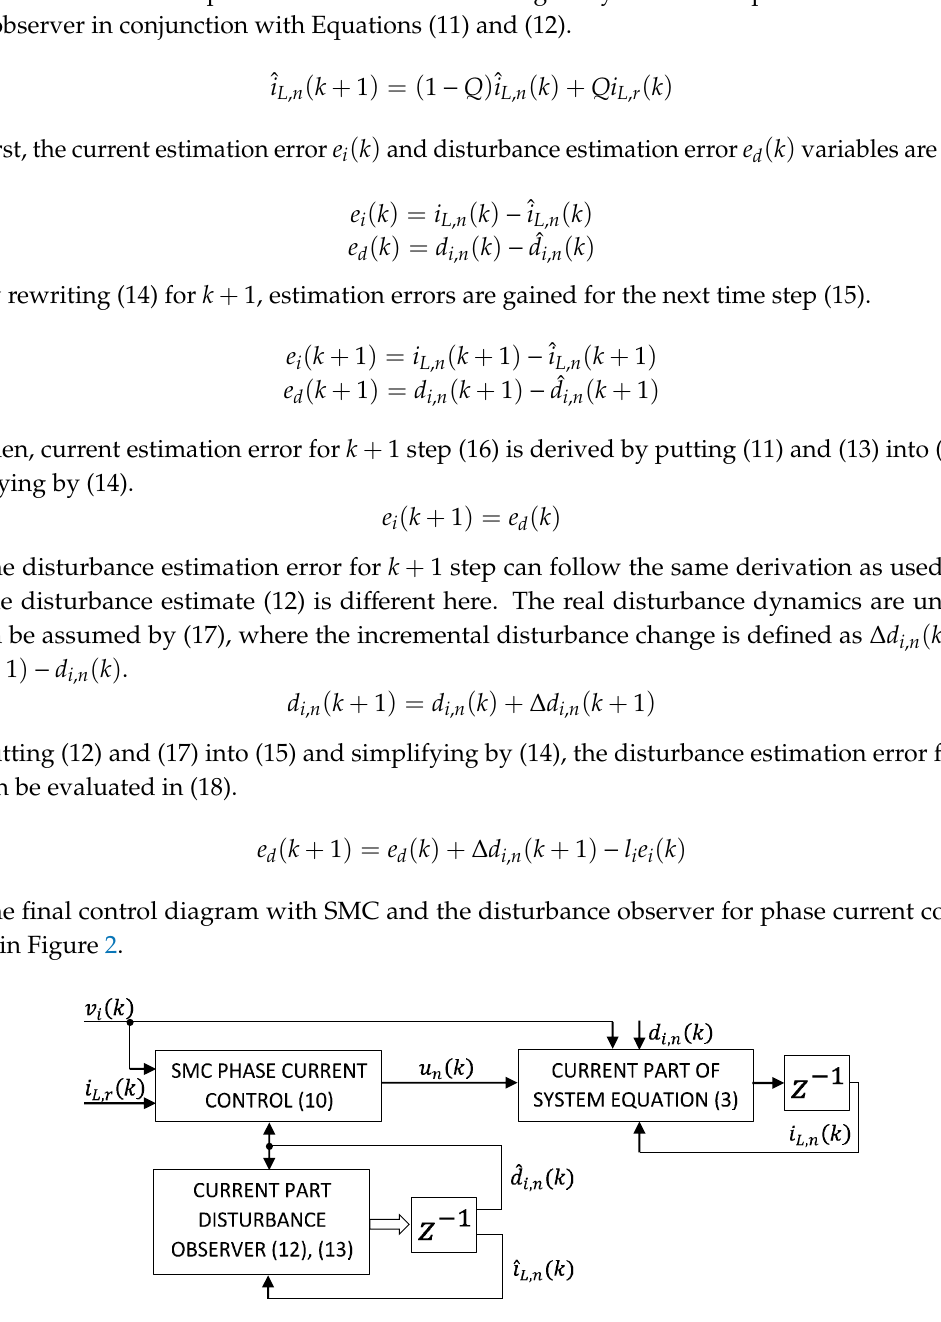
Figure 2. Diagram of sliding mode control (SMC) and disturbance observer for phase current control.